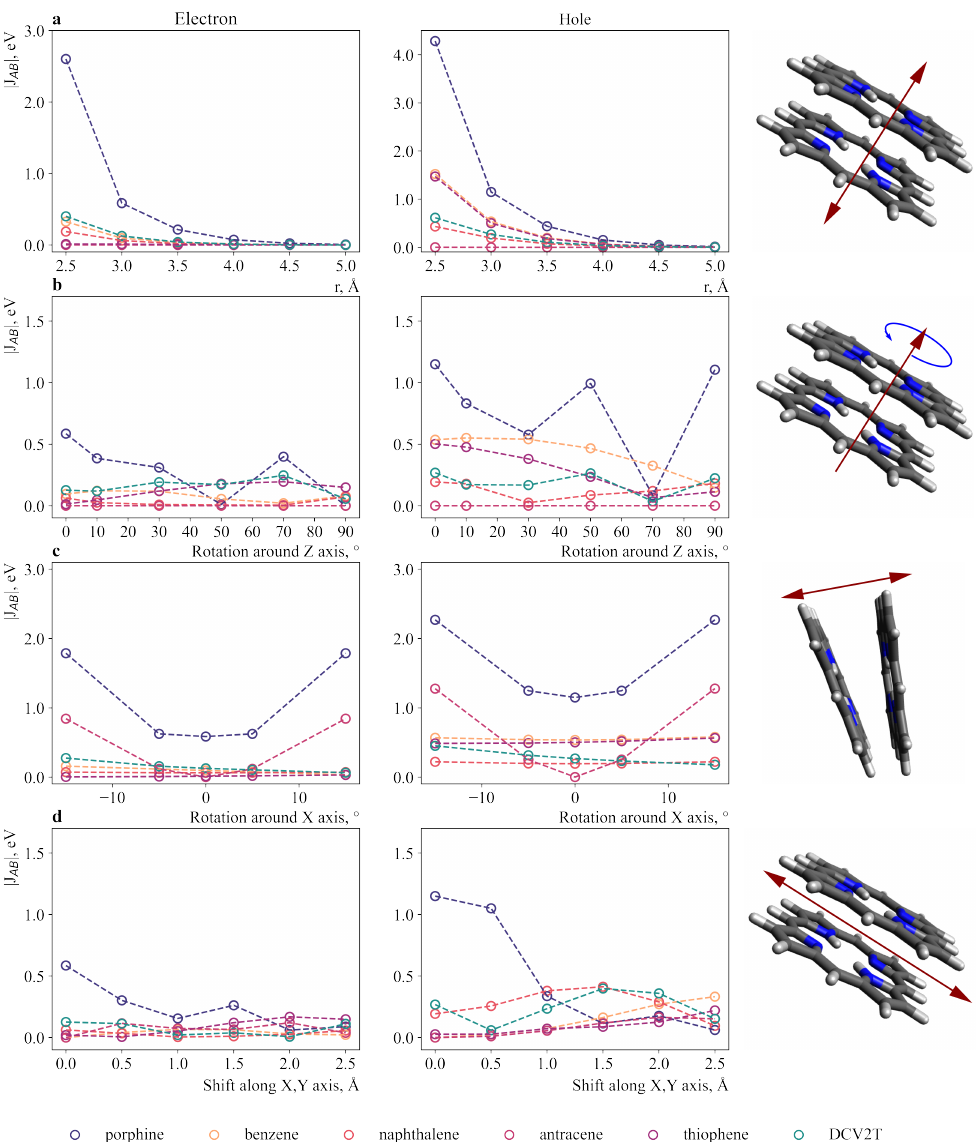
Figure 6. Change in transfer integrals between porphine and another molecule depending on: ( a ) the distance between geometric centers; ( b ) the magnitude of the angle of rotation around the normal (r = 3 Å); ( c ) the magnitude of the angle of the molecule plane’s inclination relative to the plane of porphine (r = 3 Å); ( d ) the magnitude of the shift in molecules relative to each other (r = 3 Å). Note: small molecules (benzene and thiophene) were placed above the center of the five-membered ring, and not above the center of porphine (for ( a – c